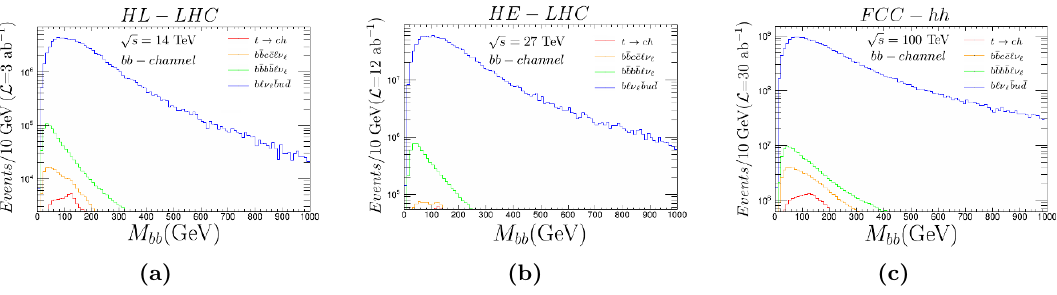
Figure 6. Invariant mass distribution of the bb system, M bb , without